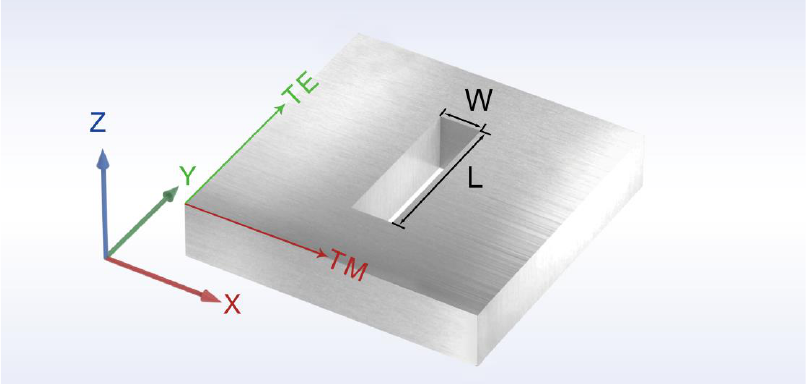
Figure 2. The numerical model of the single rectangular slot. The length and width of a single rectangular slot are L and W . The thickness of the aluminum film is 200 nm. The electric vector of the TM polarized light was along the x -axis, and the electric vector of the TE polarized light was along the y -axis. During the 3D simulation, the linear polarized light with a wavelength of 532 nm is incident along the positive direction of the z -axis. The electric vector of the TM polarized light is along the x -axis, and the electric vector of the TE polarized light is along the y -axis. A monitor is set up at a suitable location in the z -axis direction for collecting information, such as the transmittance and phase. The simulation unit is enclosed by periodic bound- ary conditions in both the x -axis and y -axis directions. Perfectly matched layers (PMLs) are employed along the z -axis direction. The accuracy of the mesh is 1 × 1 × 20 nm. The simulation period is set to 400 × 400 nm. The refractive indexes of aluminum given by Palik [59] are used in the simulations. The simulation model does not include the sub- strate. Considering the structure period and the need to prevent mutual interference in the geometric dimensions between the rectangular slots, the length of the rectangular slots is set to scan in the range of 150 – 350 nm, and the width of the rectangular slots is set to scan in the range of 20 – 150 nm. Figure 3a,b shows the phase mutation and transmittance corresponding to different sizes of the rectangular slots at a wavelength of 532 nm and an aluminum film of 200 nm.